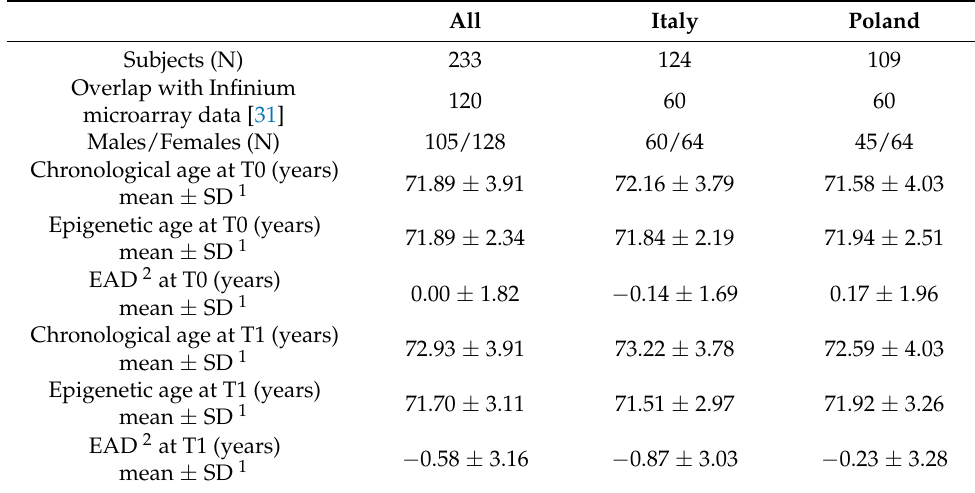
Table 2. Dataset used for the independent validation of the targeted epigenetic